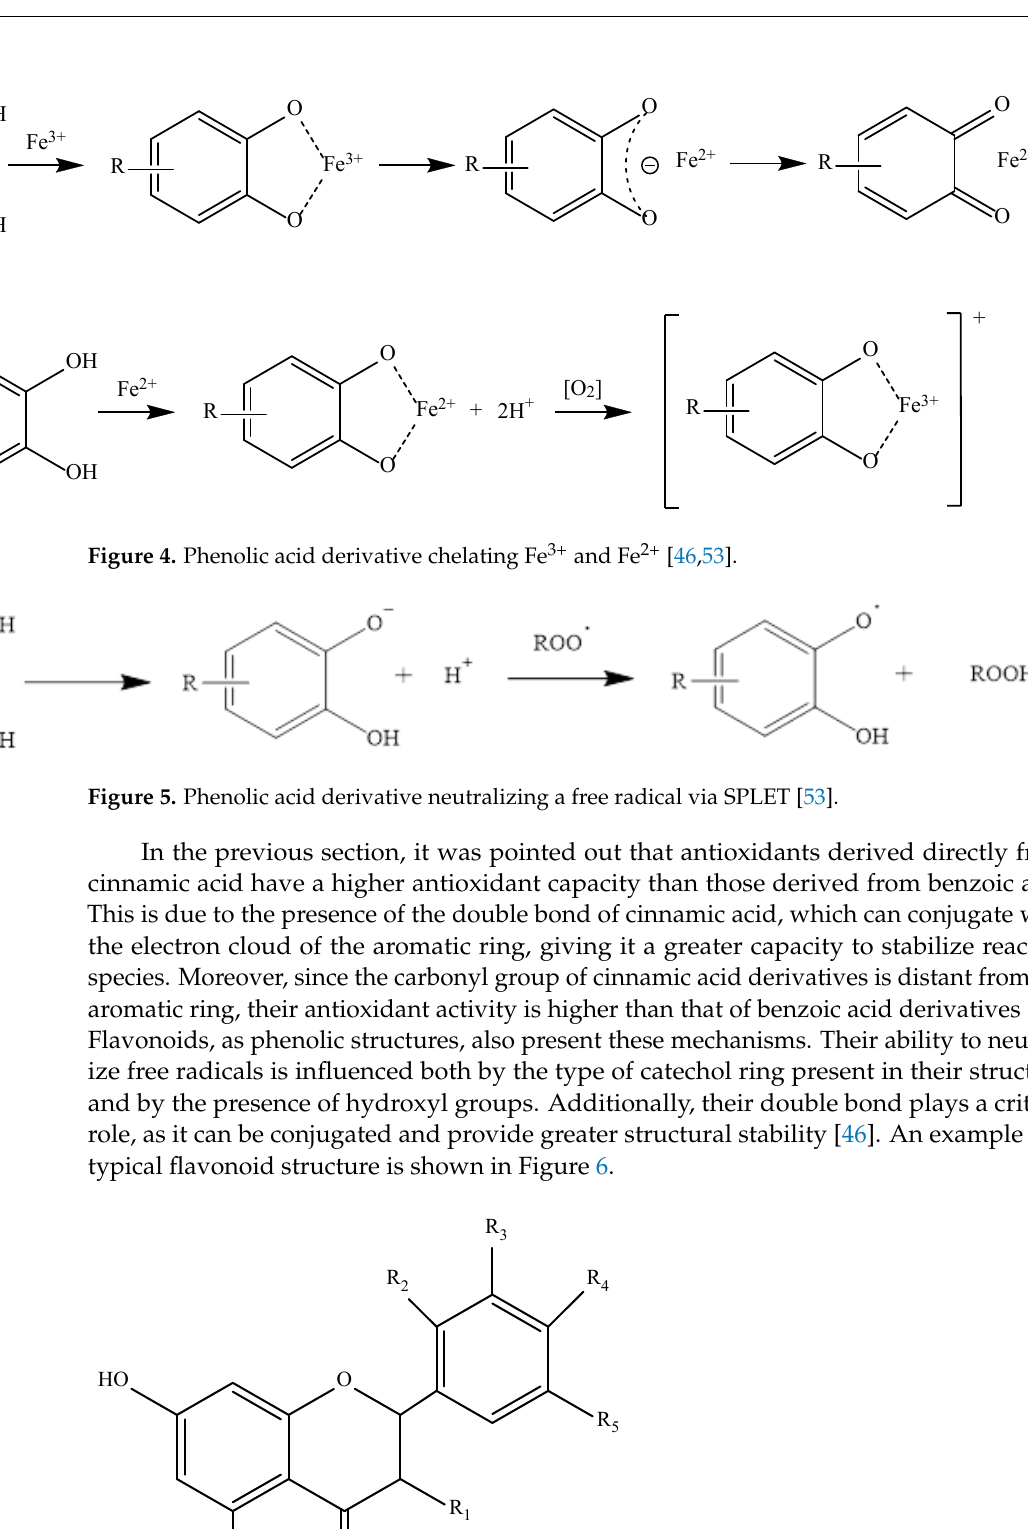
Figure 6. Most common structure of flavonoids. R1-R5 can range from hydrogen atoms to hydroxyl or methoxy groups [46].